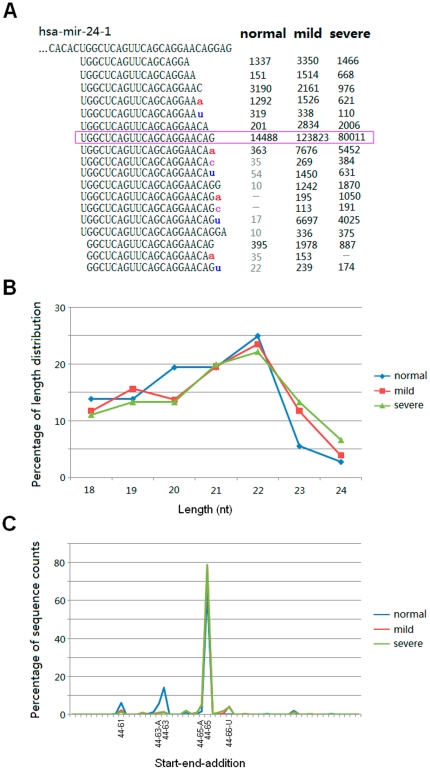
Detailed isomiRs, their length distributions and relative expression levels.Hsa-miR-24 is the most abundant miRNA in the three samples. (A) Detailed isomiRs and their sequence counts across samples. Sequence in pink box is canonical hsa-miR-24 sequence in the miRBase database. 3′ additions are highlighted by using lowercase letters in different colors. IsomiRs are not presented here if they have lower sequence counts than 100 in mild and sever samples. The signal of “—” shows sequence count of the isomiR is lower than 5 or not detected in normal sample. (B) Length distribution of isomiRs based on their sequence counts. As expected, the most dominant length is 22 nt. (C) Relative expression levels of isomiRs are estimated based on percentage of all isomiRs of hsa-miR-24. These isomiRs are showed according to start and end sites on hsa-mir-24-1 sequence. Evident differences can be detected of isomiRs with locations of 44–61, 44–63-A, 44–63 and 44–65-A.